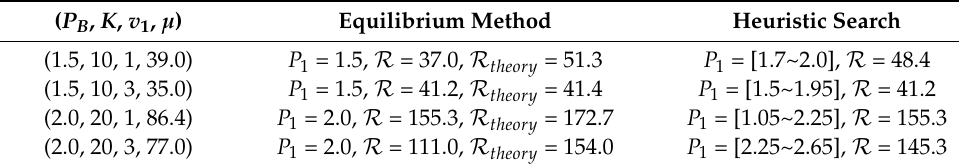
Table 9. Small capacity networks with infrequent arrival rate broadcast ( F =